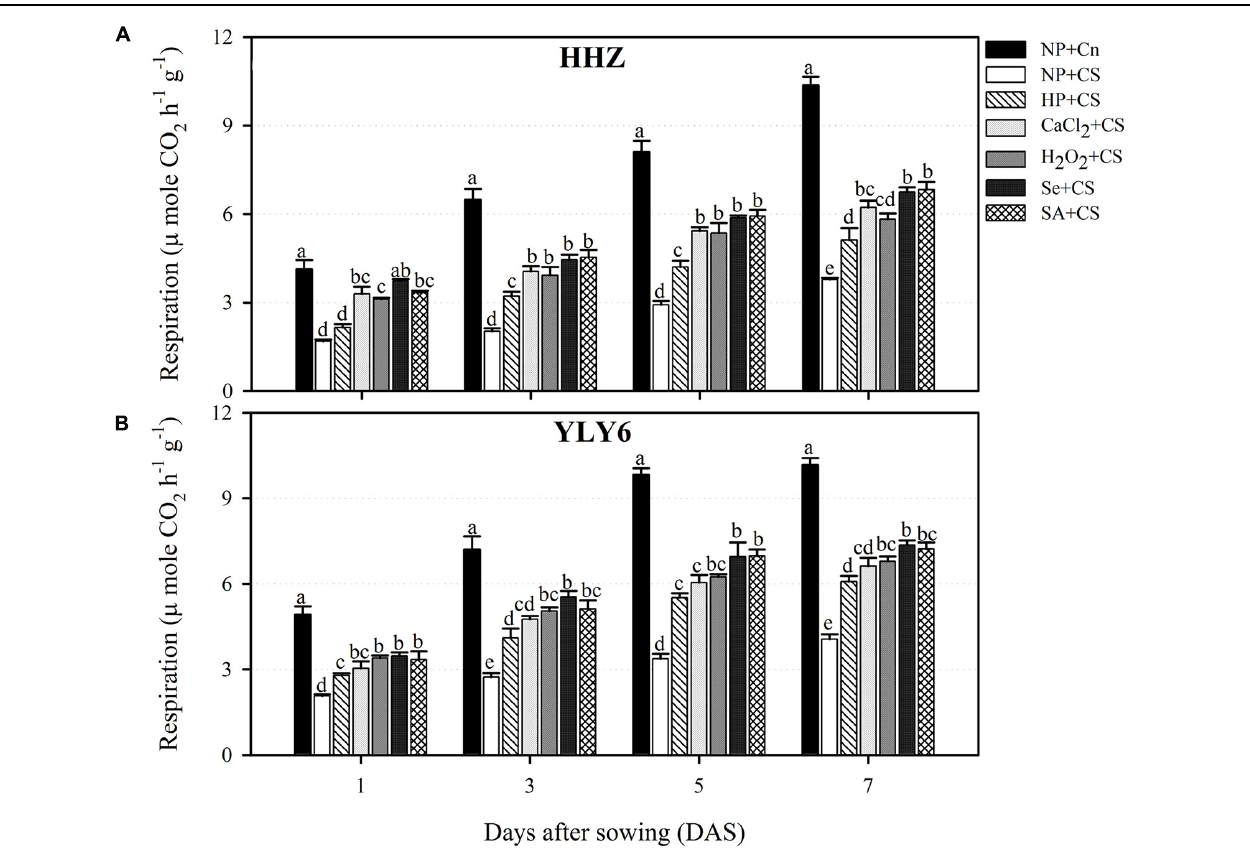
FIGURE 4 | Influence of various seed priming treatments and chilling stress on respiration rate of rice seedlings at 1, 3, 5, and 7 DAS in two cultivars, (A) HHZ, and (B) YLY6. Vertical bars above mean indicate standard error of six replicates. Mean value for each treatment with different lowercase letters indicate significant differences by the LSD-test ( P < 0.05). NP + Cn: no priming and no stress, NP + CS: no priming and chilling stress, HP + CS: hydropriming and chilling stress, CaCl 2 + CS: calcium chloride priming and chilling stress, H 2 O 2 + CS: hydrogen peroxide priming and chilling stress. Se + CS: selenium priming and chilling stress, and SA + CS: salicylic acid priming and chilling stress, Cn: 28 ◦ C, CS: 18 ◦ C, HHZ: inbred cultivar huanghuazhan, YLY6: hybrid variety